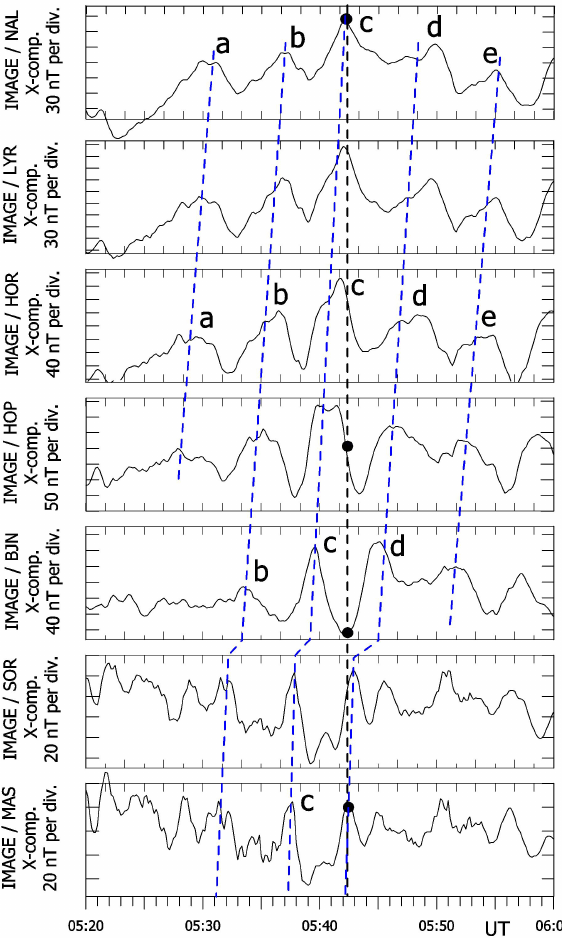
Fig. 8. Same format as in Fig. 3, for the event of day 341, 1994. In particulary, we pay attention to the dispersive peaks marked with the letters (a), (b) and (c), as well as to the double phase change of 180 ◦ which occurred at ∼ 05:42 UT.